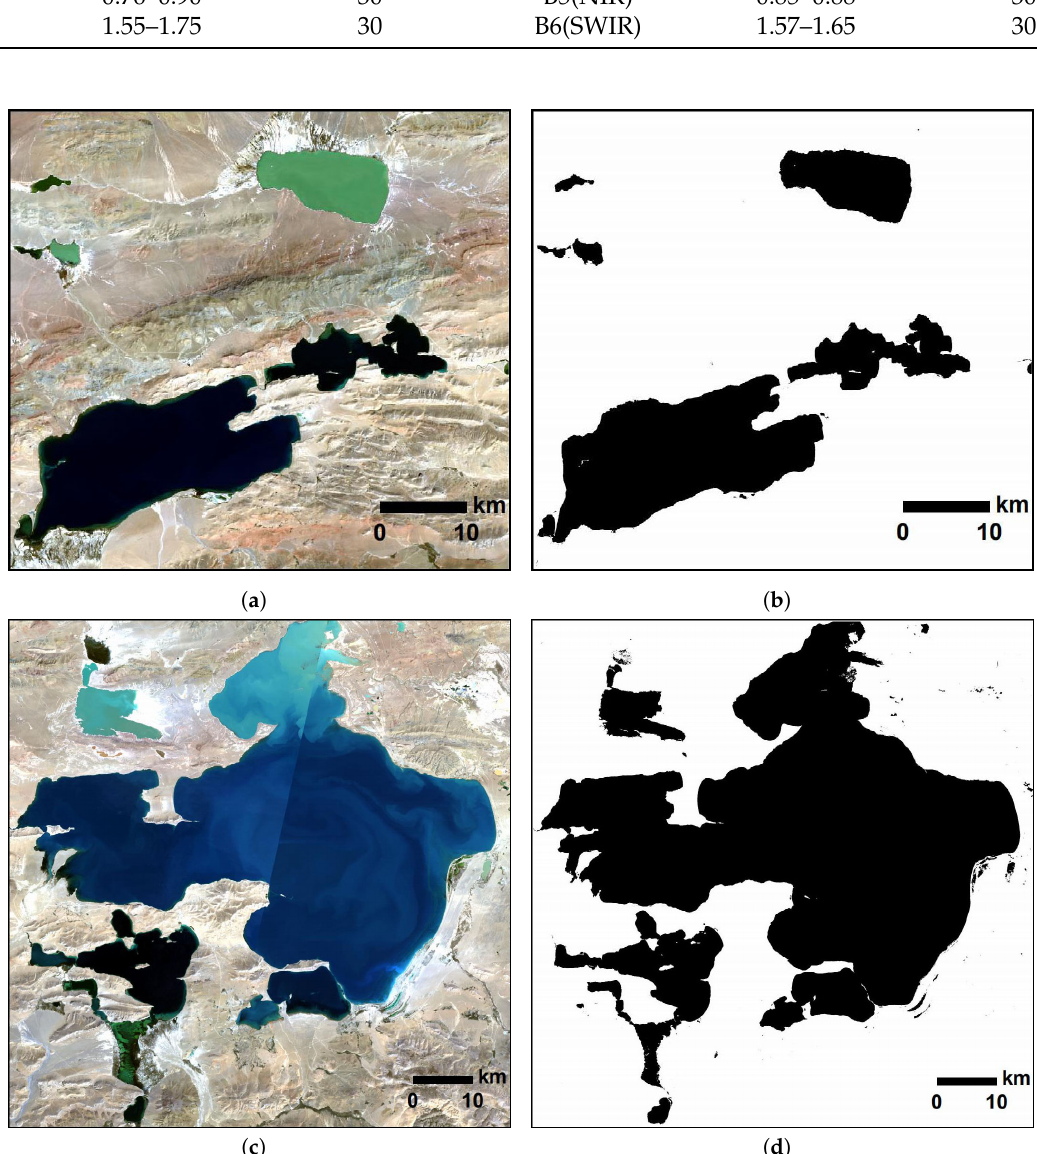
Figure 3. Example of the subsets used for training and testing data. ( a , b ) An example of training subset and its corresponding binary label image. ( c , d ) An example of testing subset and its corresponding binary label